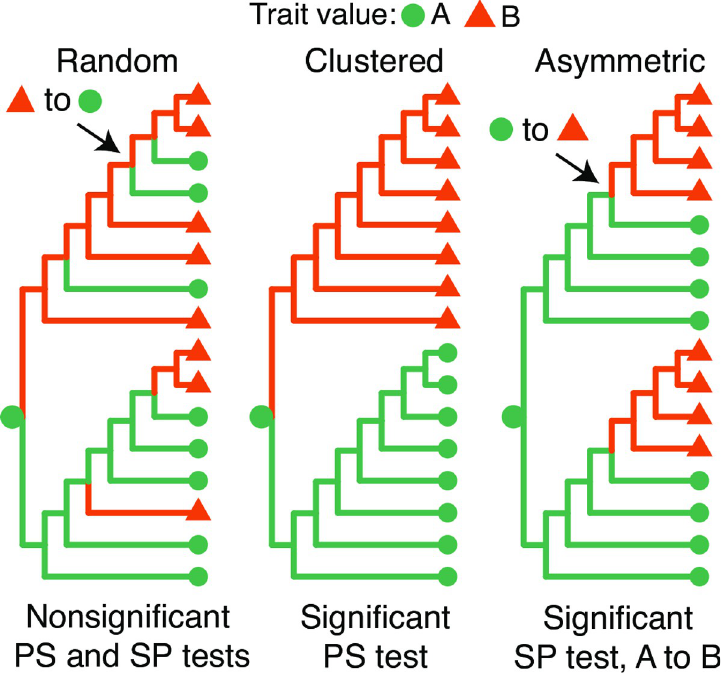
Fig 1. Hypothetical phylogenetic trees used to illustrate tree/trait association statistics. Trait values at internal nodes of the tree are inferred using maximum parsimony given the trait values at the tips, which are shown using different colors and shapes. Two example state changes are highlighted. (left) No association between tip-trait values and tree : Distribution of traits across this tree is indistinguishable from randomly distributed traits by any statistic used. (middle) Tip-trait values clustered in tree : Cells with the same trait value are more closely related to each other in the tree, which will yield significantly fewer switches than in the same tree with permuted tips, and therefore a significantly low PS statistic. (right) Asymmetric ancestor/descendant relationships among trait values : All switches in this tree are from A to B ( SP = 1), significantly higher than expected from the same tree with permuted tips. This indicates an asymmetric relationship between these states along the tree.